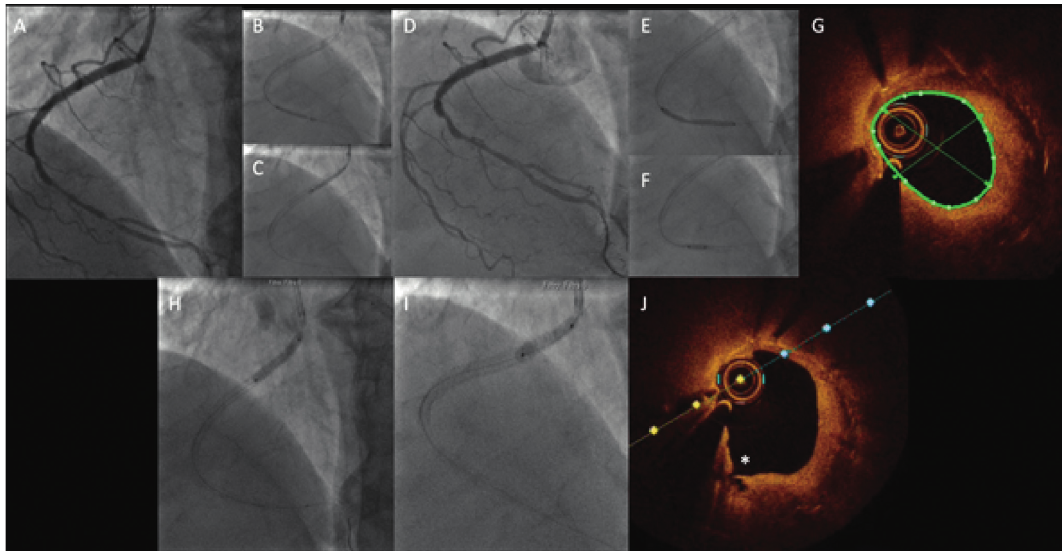
Figure 4: NSTEMI patient undergoing PCI with the SCB of de novo lesion with a 3-month angiographic follow-up. A patient with NSTEMI and a significant stenosis in the proximal segment of a collateral branch (small diameter but good extension) of the I diagonal (a); the lesion was treated with a 2.0 × 12mm noncompliant balloon (b) and a 2.25 × 15mm SCB (c) with good final angiographic result and TIMI 3 flow (d). The angiographic follow-up at 3 months is reported (e) with no restenosis nor thrombosis of the treated